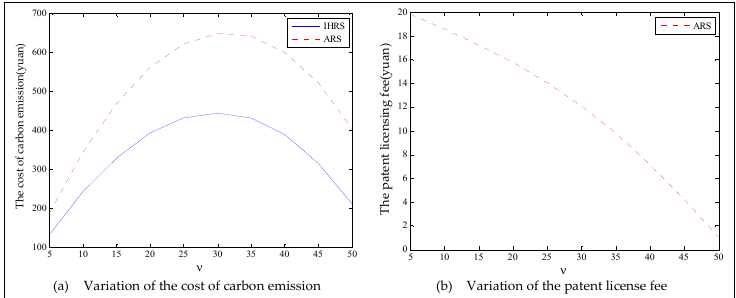
Figure 9. Changes in the costs of carbon emission and the patent licensing fee in Case 2 of Section 6.1.